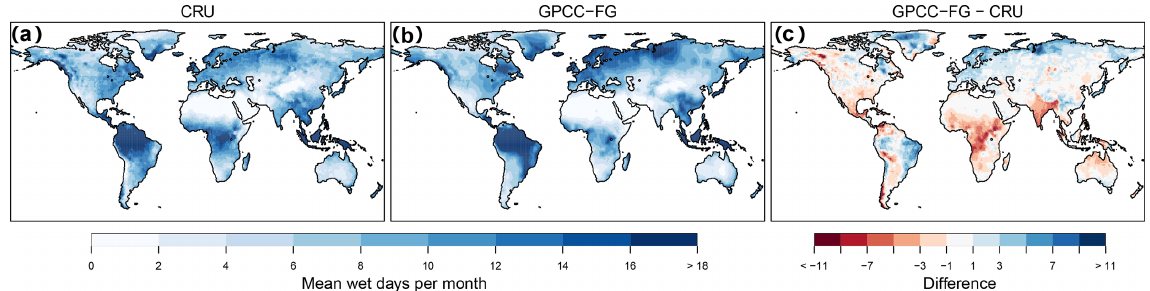
Figure 3. Comparison of the number of wet days provided by (a) the CRU data set, compared to those derived from (b) GPCC-FG, and (c) the difference between the two for the period